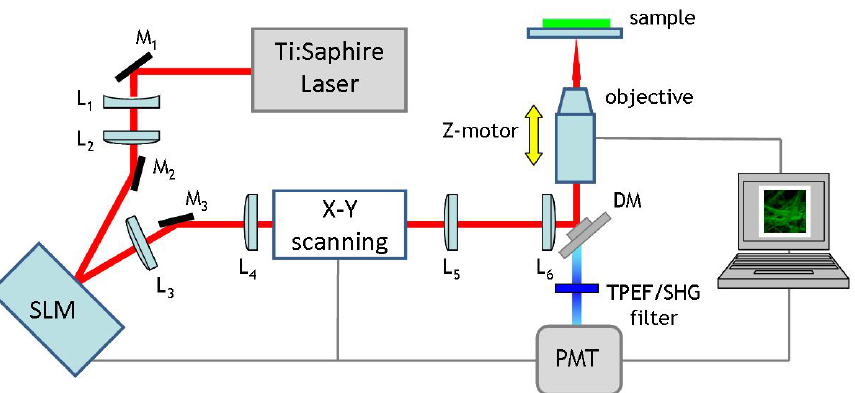
Figure 1. Schematic diagram of the MP microscope used for the purpose of this work. L 1 -L 6 , lenses; M 1 -M 3 , mirrors; DM, dichroic mirror; SLM, spatial light modulator; PMT, photo-multiplier tube. Further details about the different components and optical elements can be found in [6,27].